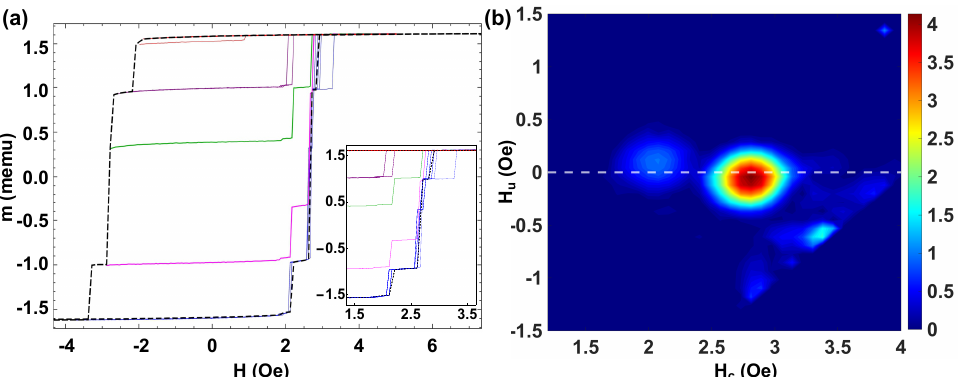
Figure 6. ( a ) MHL (black line) and FORC curves (color lines) for a set of five microwires with H 0 = { 2.69,2.74,2.86,3.08,3.29 } Oe. ( b ) Corresponding FORC diagram for this set of microwires.